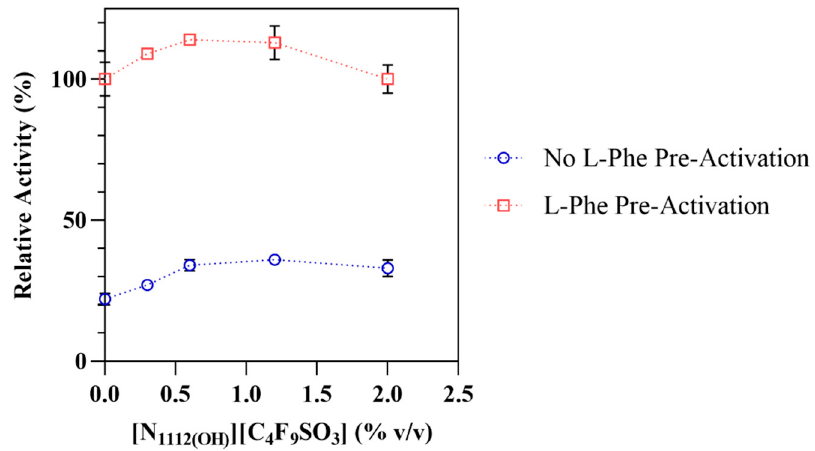
Figure 2. Relative activities of hPAH as a function of [N 1112(OH) ][C 4 F 9 SO 3 ] concentrations. Relative enzymatic activity of non-activated and L-Phe activated hPAH. The activity of the hPAH in the absence of [N 1112(OH) ][C 4 F 9 SO 3 ] in the preactivated assay (1 mM L-Phe) was considered as 100%. Data are shown as mean ± SD of triplicate assays.